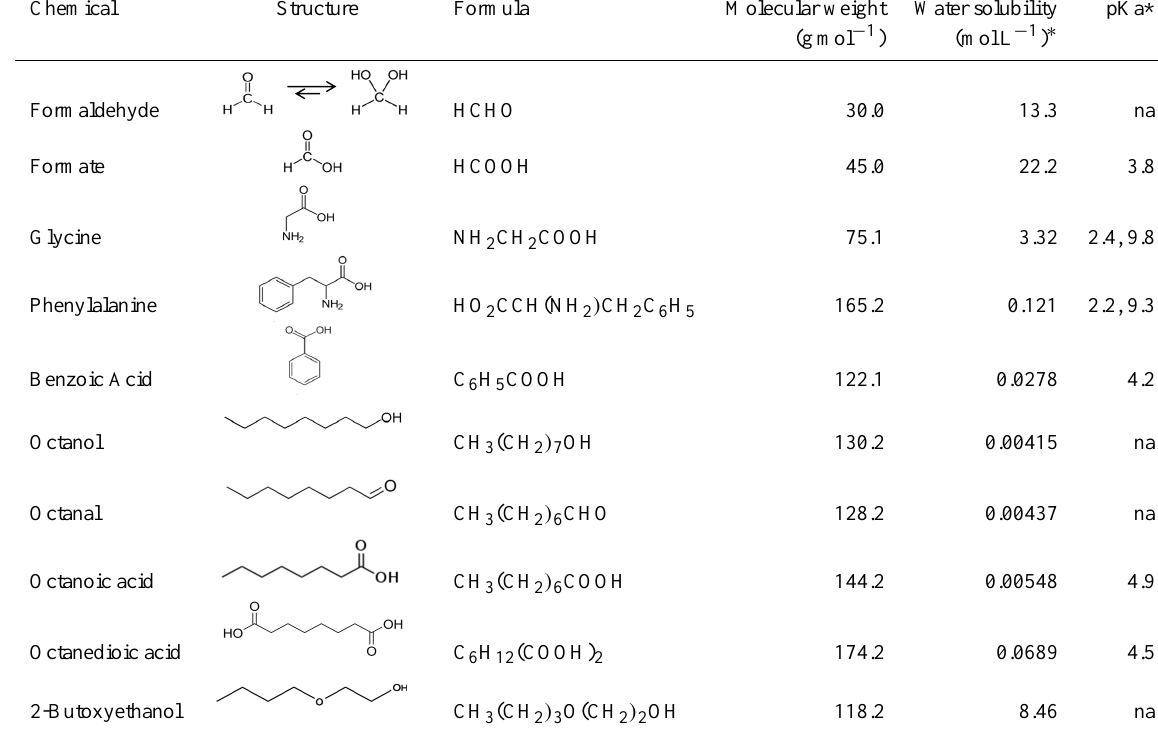
Table 1. Physical and chemical properties of model organic compounds.